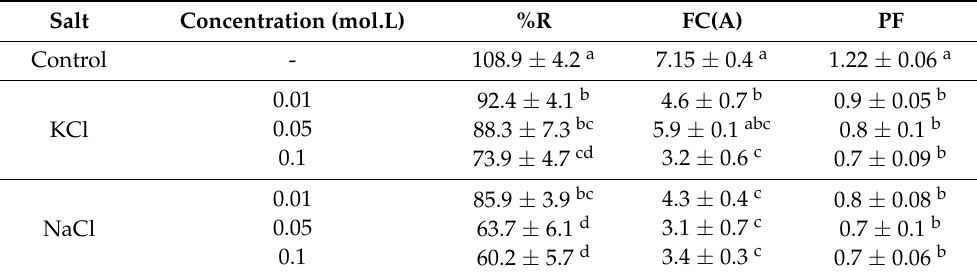
Table 2. Effects of ionic strength on the enzyme concentration and purification using a 50 kDa membrane at pH 7.5 and 1.5 kgf/cm 2 of operating